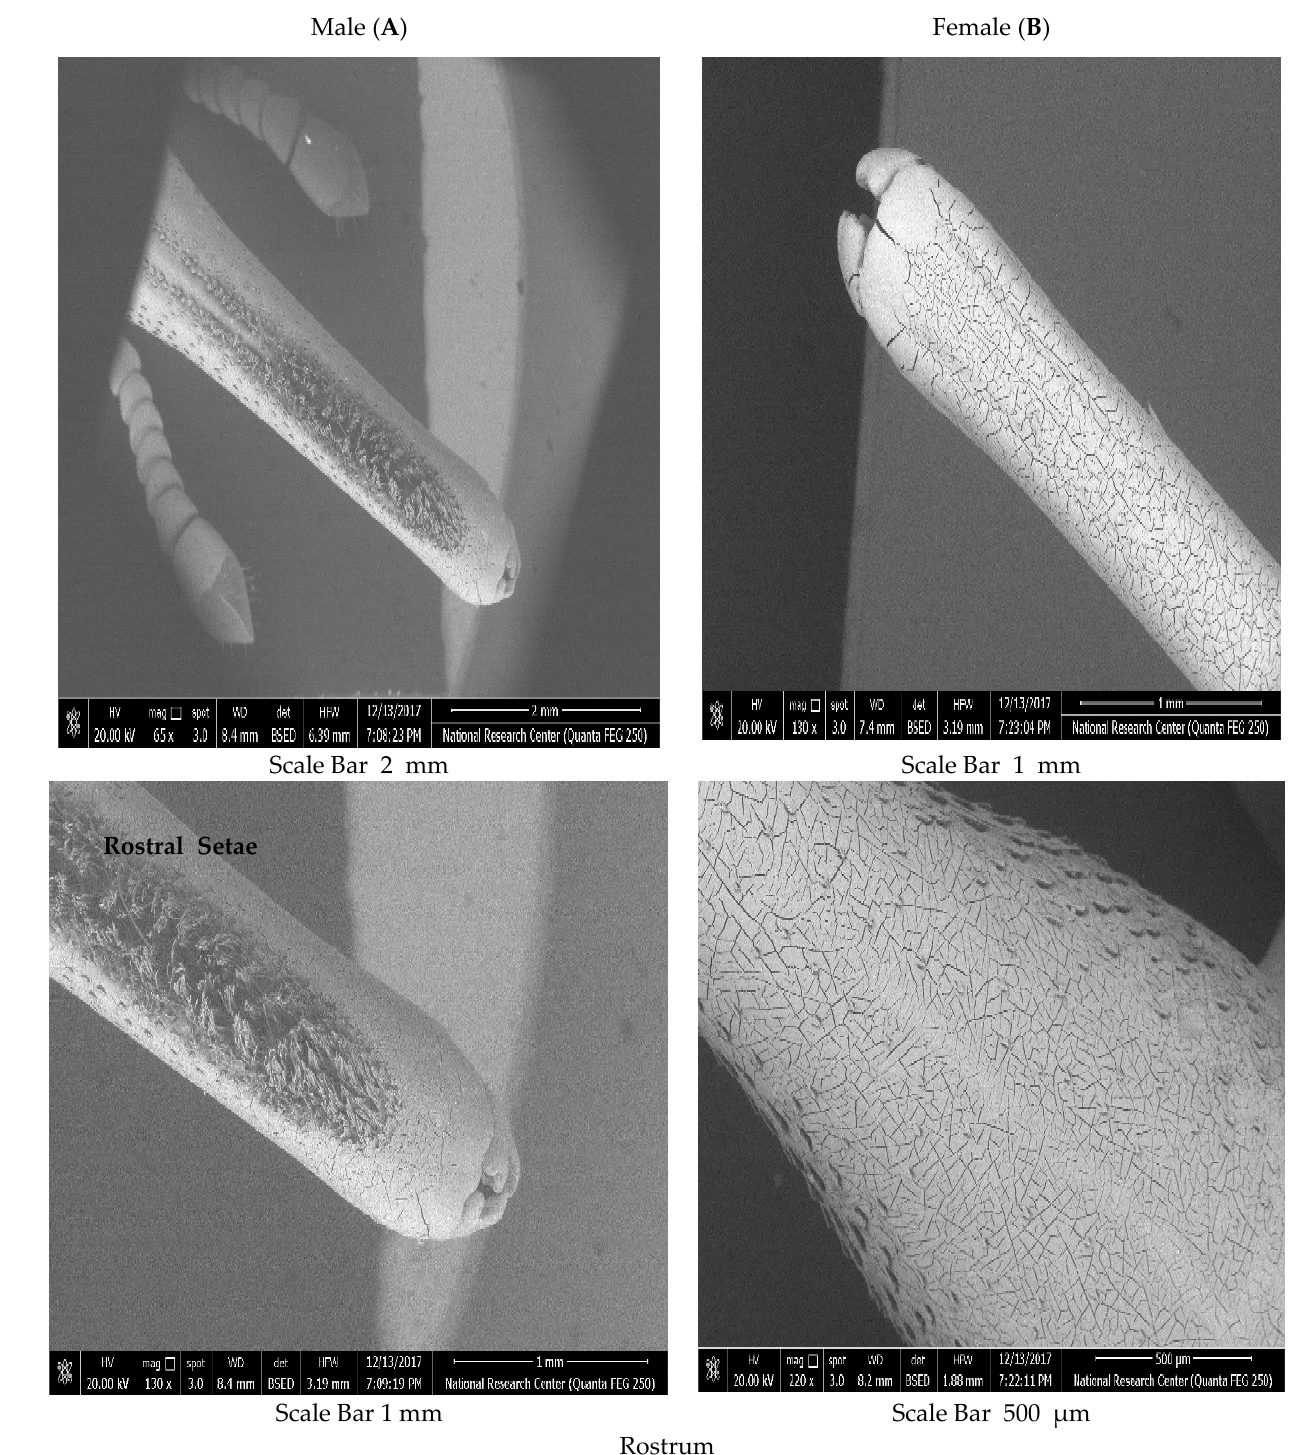
Figure 3. Scanning electron microscopy (SEM) image of Rostrum of R. ferrugineus male ( A ) and female ( B ) adults, showing the sexual dimorphism between adults, indicating high variability (note: p > 0.05, n = 13 random individuals/sex), (scale bar below each picture and measurements are shown in the picture). N.B. adults brought from different geographical locations during 2019.